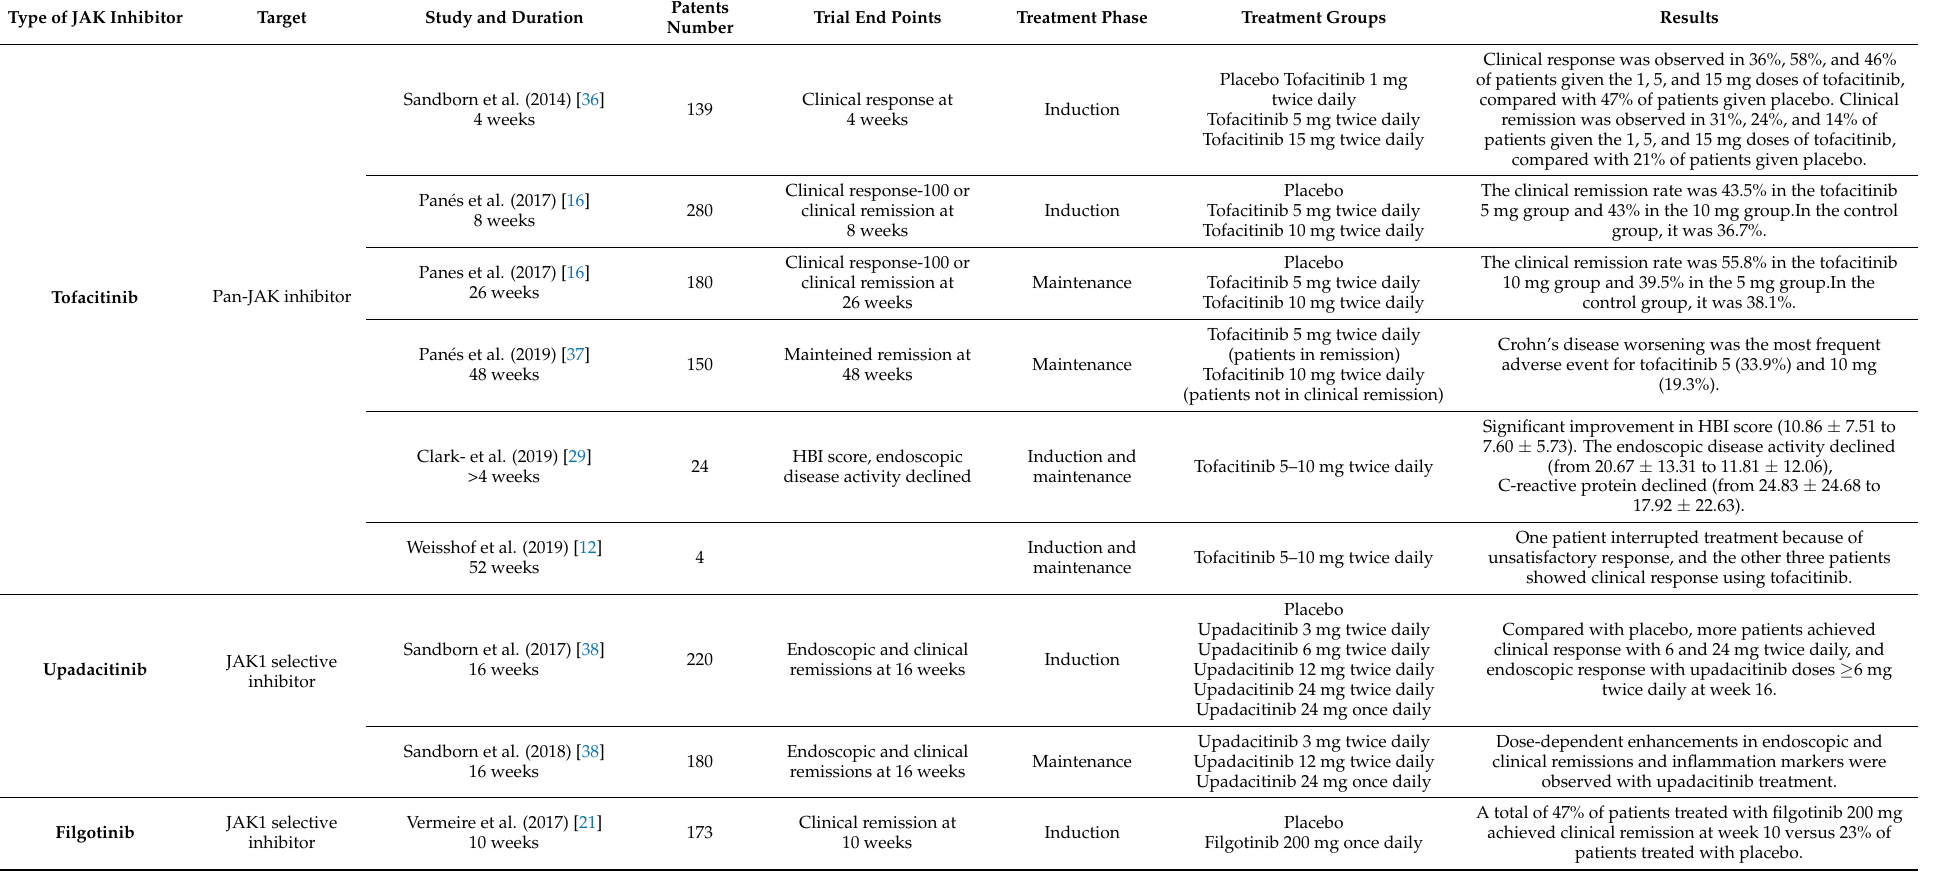
Table 2. JAK Inhibitors for CD